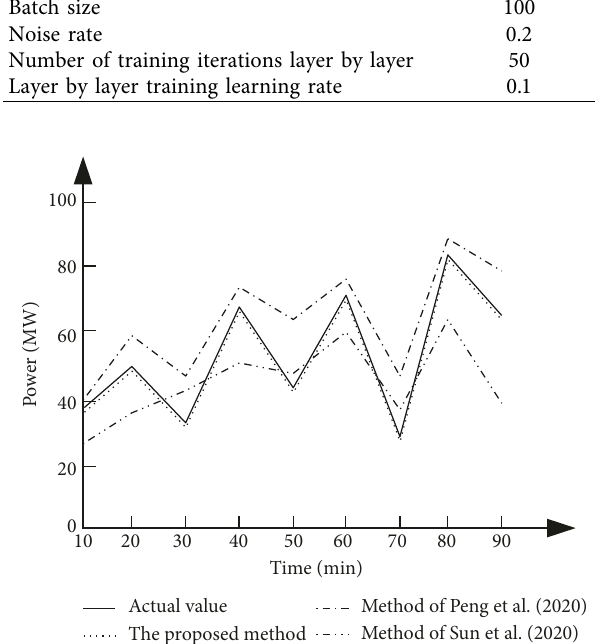
Figure 6: Comparison results for different methods of offshore wind turbine generating power prediction